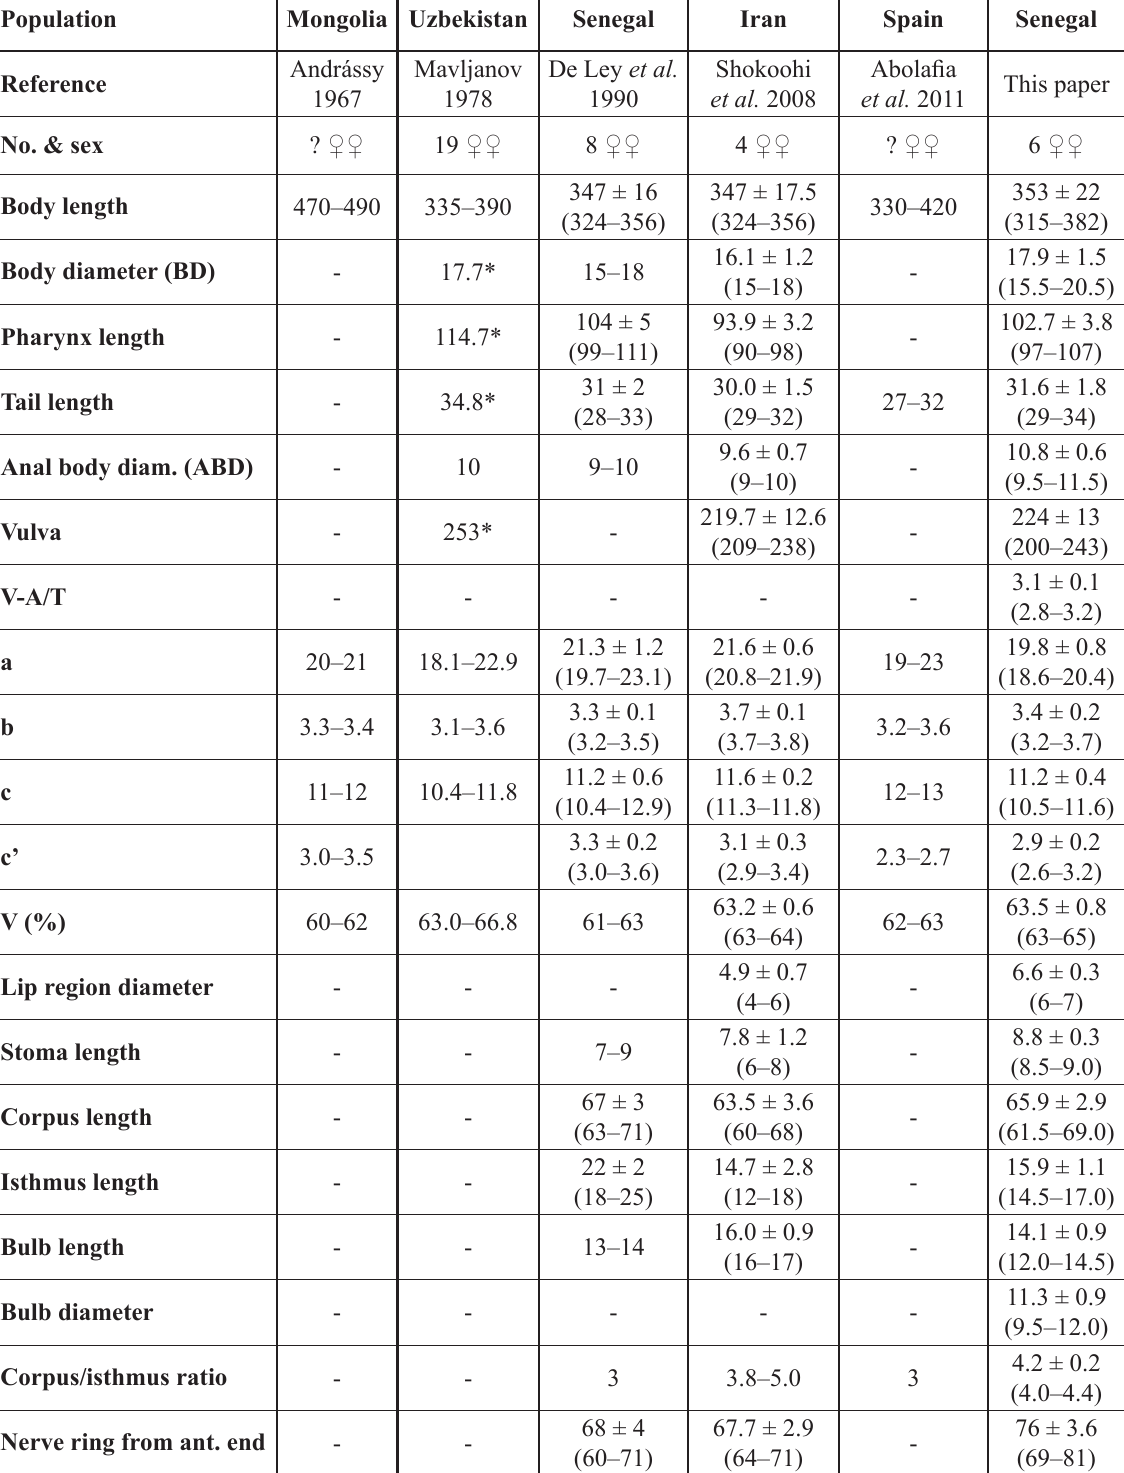
Table 3. Measurements of females of Stegelleta ophioglossa Andrássy, 1967 from Senegal compared with other populations of the same species (presented as mean ± s.d. and (range) or only range). * Calculated from data in original publication. ** Number of annuli from anterior end to nerve ring, excretory pore and deirid, respectively; - indicates that data is not available or not